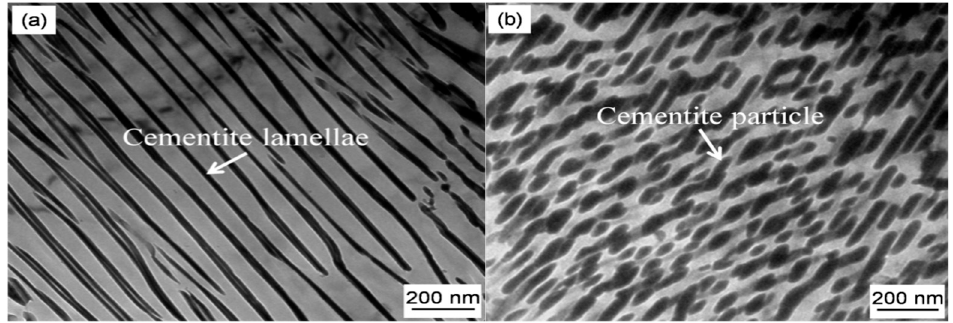
Figure 9. TEM micrographs of Alloy 1 at a cooling rate of 0.1 °C/s; ( a ) cementite lamellae, and ( b ) cementite particle.